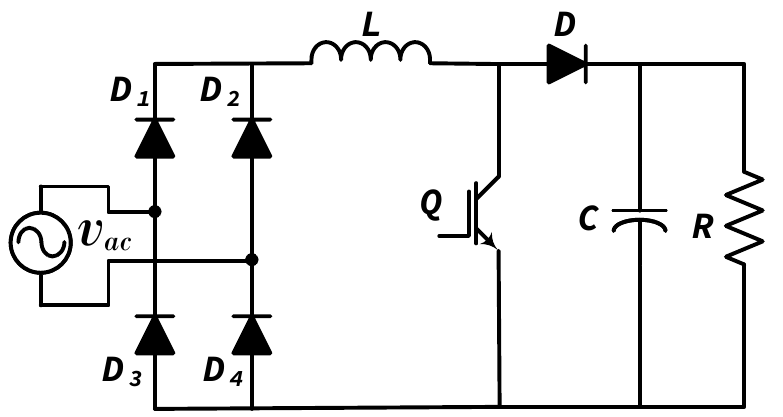
Figure 1. Conventional BBC topology with